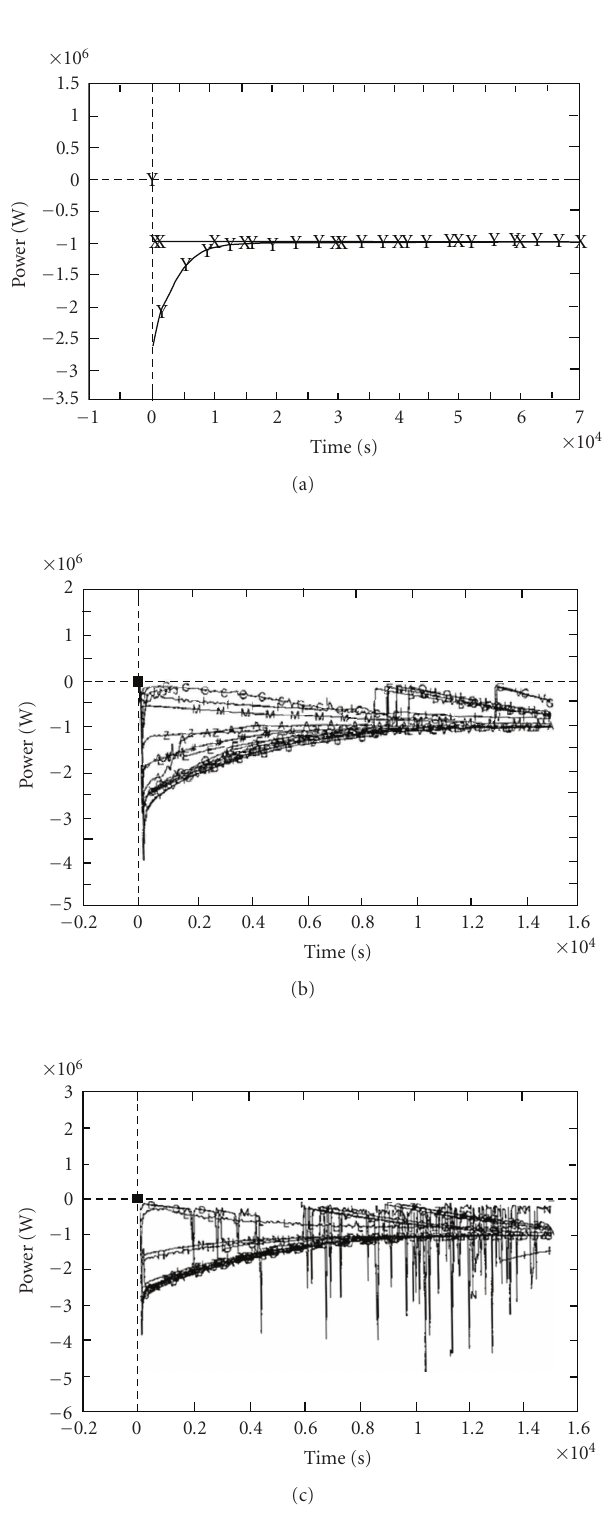
Figure 18: (a) Reference system performance: power exchanged through the IC. (b) Time trends related to the ensemble of 75 code runs (6 deterministic status and 69 probabilistic status— discrete probability distribution): power exchanged trough the IC. (c) Time thrends related to the ensemble of 75 code runs (6 deterministic status and 69 probabilistic status—continuous probability distribution): power exchanged through the IC.